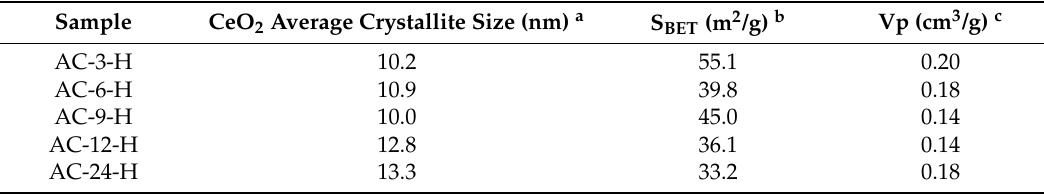
Table 1. Structural information of the different